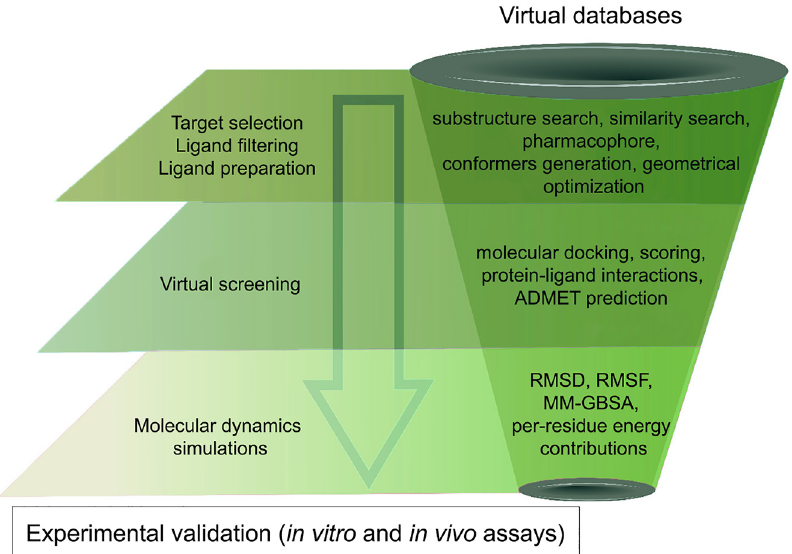
Figure4: State-of-the-artvirtual screeningmethodologytoselect and study natural